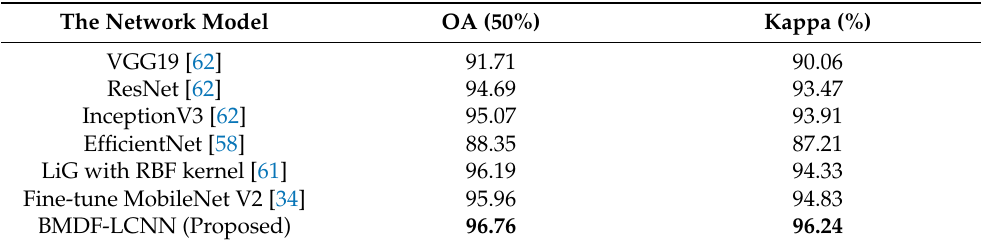
Table 7. Comparison of Kappa results between the proposed model and other advanced methods on the AID